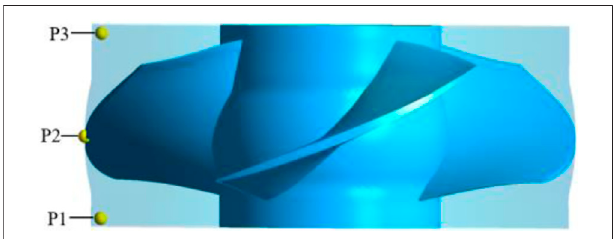
FIGURE 11 | Distribution of monitoring points of the